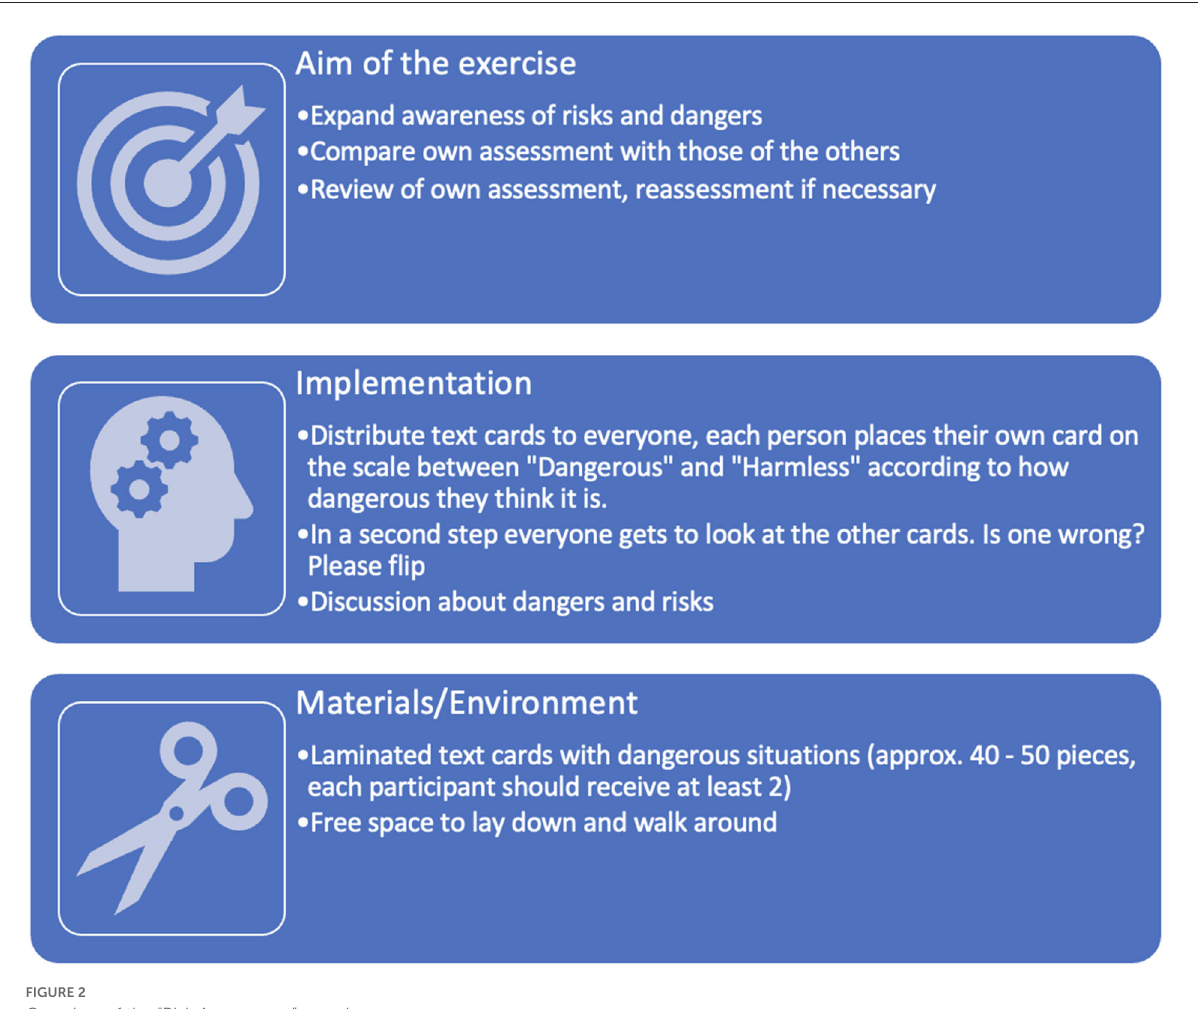
FIGURE2 Overview of the “Risk Assessment”